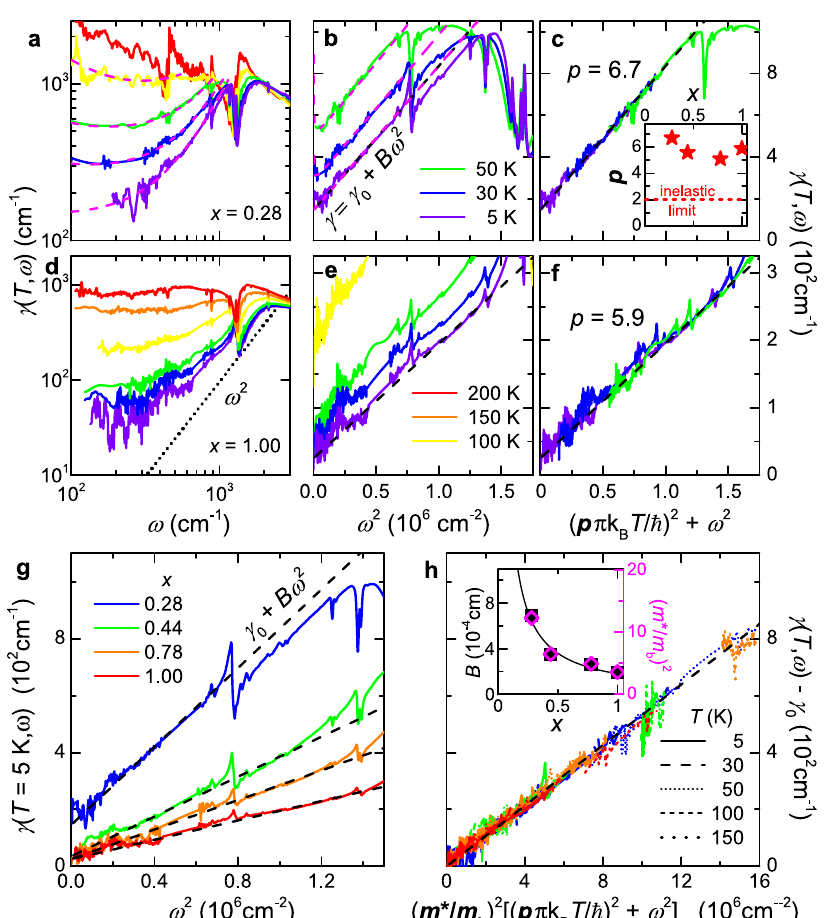
Fig. 3 Fermi-liquid scaling of optical scattering rate obtained from extended Drude analysis. a , d γ ( T , ω ) acquires a pronounced frequency dependence at low T , here shown for x = 0.28 and 1.00. b , e ω 2 behavior persists well above T FL ; note the quadratic frequency scales. Dashed pink lines in a , b are fi ts to Eq. (2). c , f Curves recorded at different T collapse on a generalized quadratic energy scale (see Eq. (1)) for a speci fi c Gurzhi parameter p > 2, as shown in the inset. g Comparing γ ( ω ) at 5 K for x ≥ 0.28 reveals that the slope of B ω 2 increases towards the Mott MIT, similar to AT 2 in dc transport (Fig. 2h – k). h Rescaling the energy dependence by ð m ? = m b Þ 2 (see Supplementary Fig. 10) collapses all data on a universal scaling curve, which follows from 2 . The 5, 30, and 50 K data are shown for all four substitutions (color code like in g ); the scaling holds even for T ≥ 100 K for x ≥ 0.44. In B / ð m ? = m b Þ panels b , c , e , f , h only the range below the vibrational features at 880 or 1200 cm − 1 is